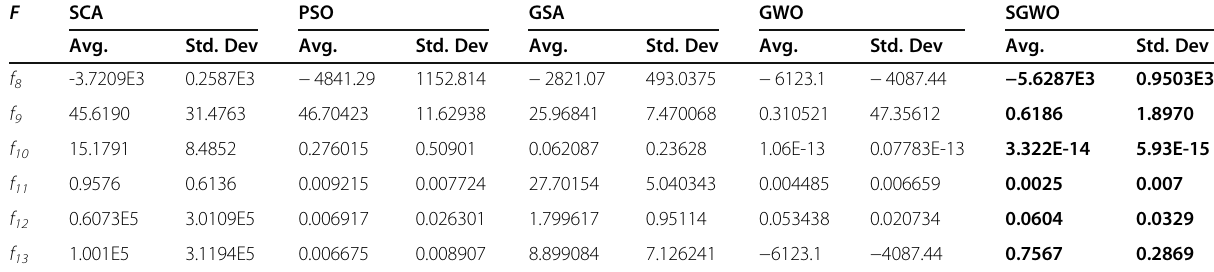
Table 2 Comparison of proposed SGWO with other techniques for multimodal benchmark test